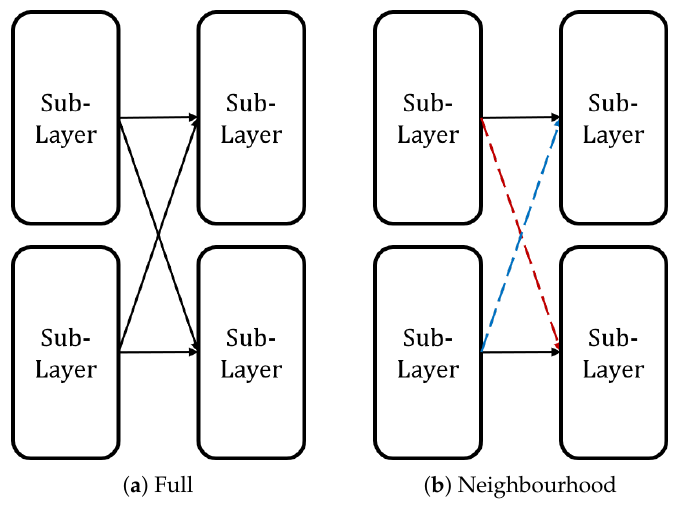
Figure 3. Full connection and neighbourhood